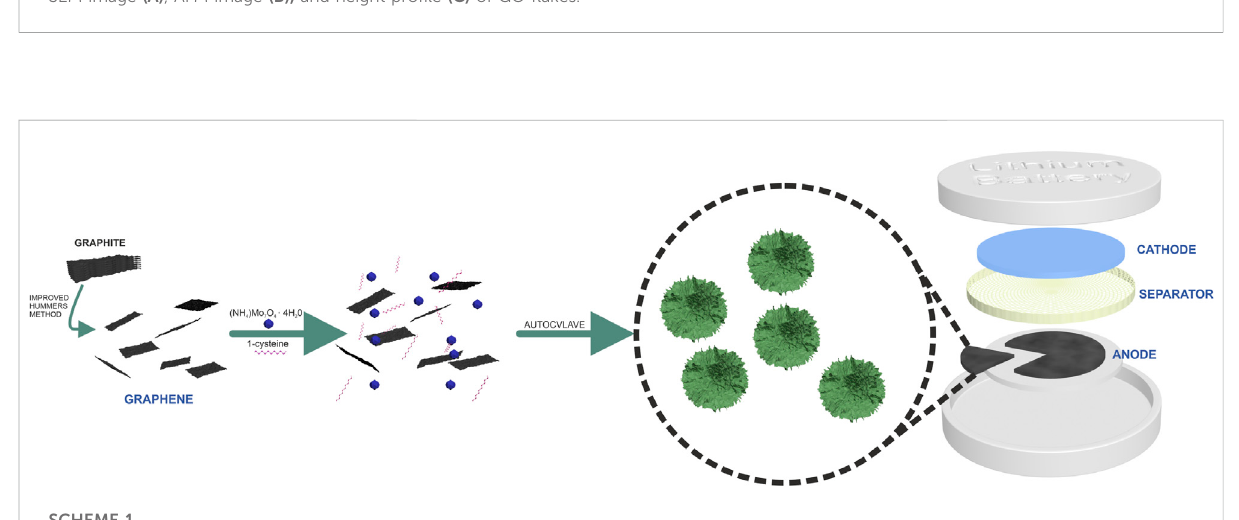
FIGURE 1 SEM image (A) , AFM image (B), and height pro fi le (C) of GO fl akes.